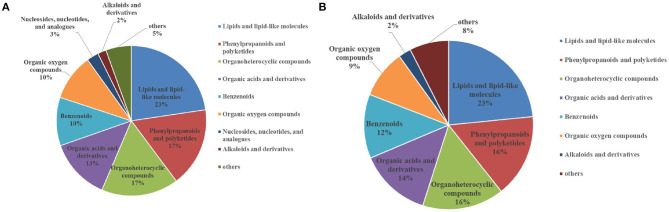
Superclass pie chart of differential metabolites between NG8 and G8 (A) and between NG12 and G12 (B).